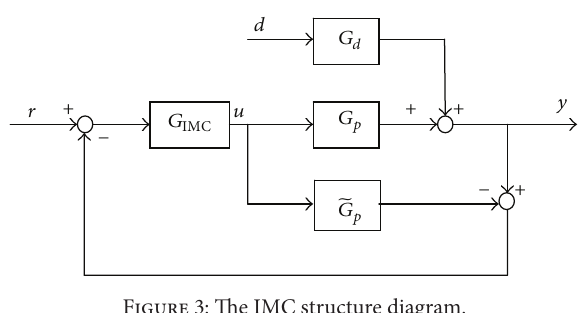
Figure 3: The IMC structure